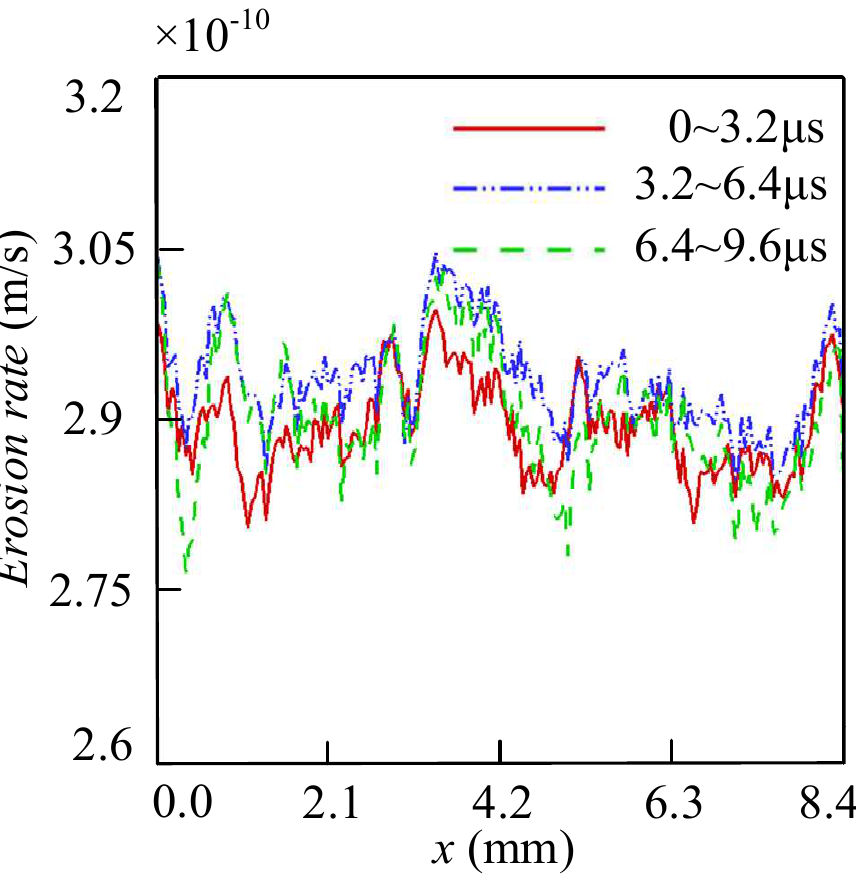
Figure 6. The erosion rate of the dielectric wall along the azimuthal direction in different time periods with E ⊥ B .